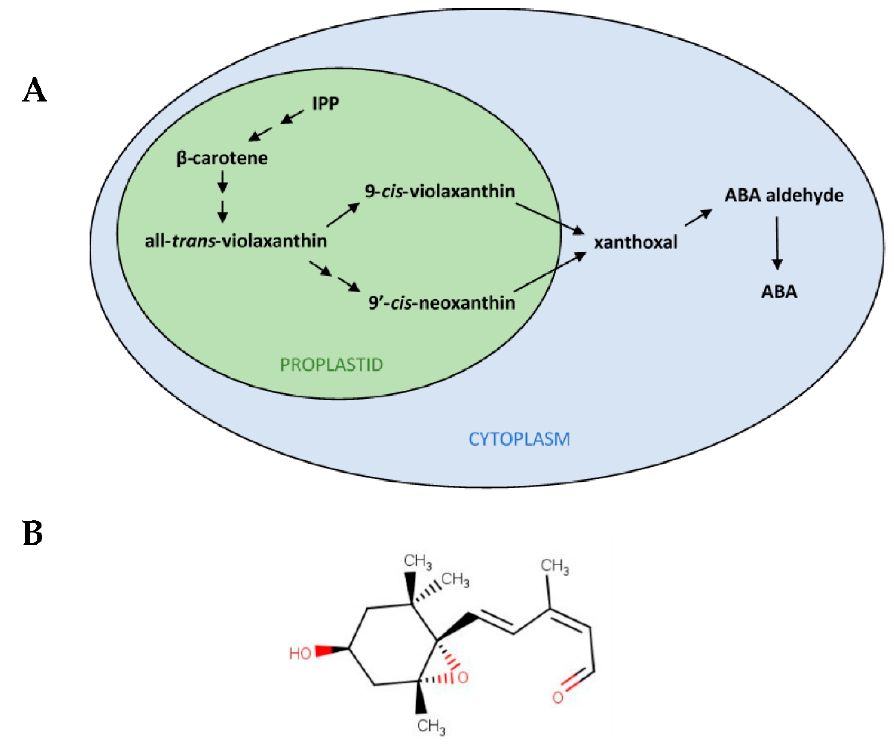
Figure 1. Xanthoxal features. ( A ) Scheme of the abscisic acid (ABA) biosynthesis pathway in plants. ABA synthesis proceeds from the carotenoid pathway, which starts from the precursor isopentenyl pyrophosphate (IPP), a C 5 (five carbon atoms molecule), and, through β -carotene, a C 40 , produces epoxydic xanthophylls, such as all- trans -violaxanthin, still a C 40 . By isomerization, 9 ′ - cis -neoxanthin and 9- cis -violaxanthin are further obtained, which can be oxidatively cleaved by 9- cis -epoxycarotenoid dioxygenases (NCEDs) in the first specifically committed step of ABA synthesis, resulting in the production of xanthoxal, a C 15 . Up to the C 40 to C 15 conversion, which is the rate-limiting step of ABA biosynthesis, the pathway takes place in the plastids (proplastids, in seeds). Thereafter, in the cytoplasm, ABA (still a C 15 ) is synthesized from xanthoxal through ABA aldehyde. Double arrows indicate multiple biosynthetic steps. ( B ) Chemical structure of cis , trans -xanthoxal (oxygen residues are evidenced in red), the biologically active form of xanthoxal.